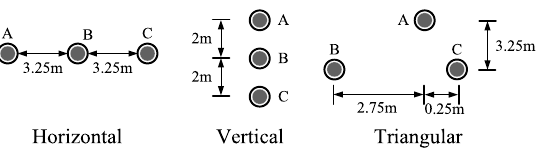
Fig. 7 Different arrangement of three-phase conductors